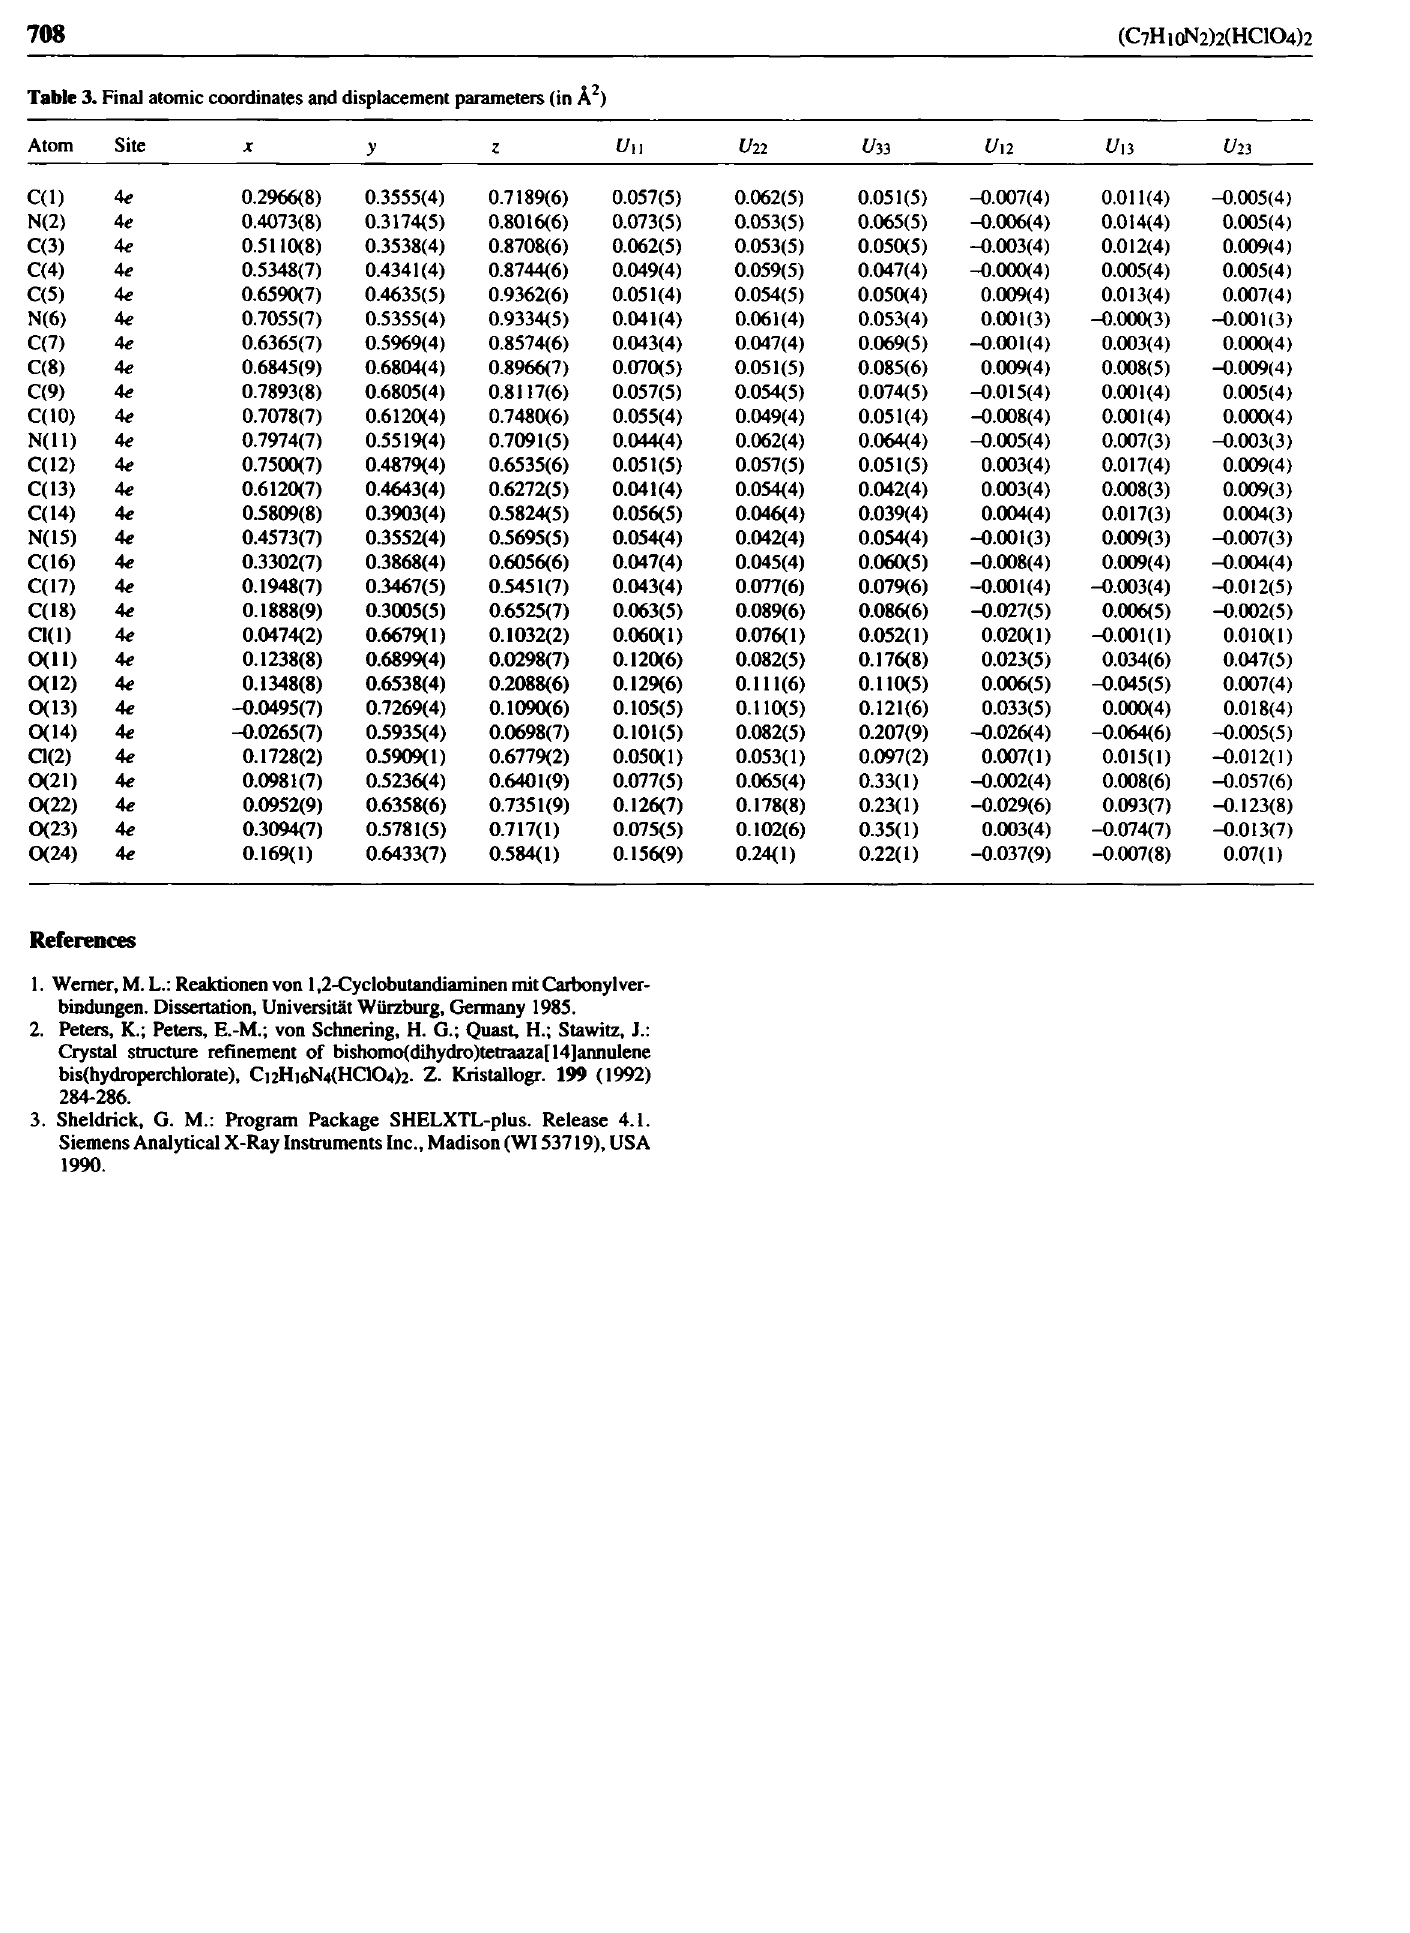
Table 3. Final atomic coordinates and displacement parameters (in